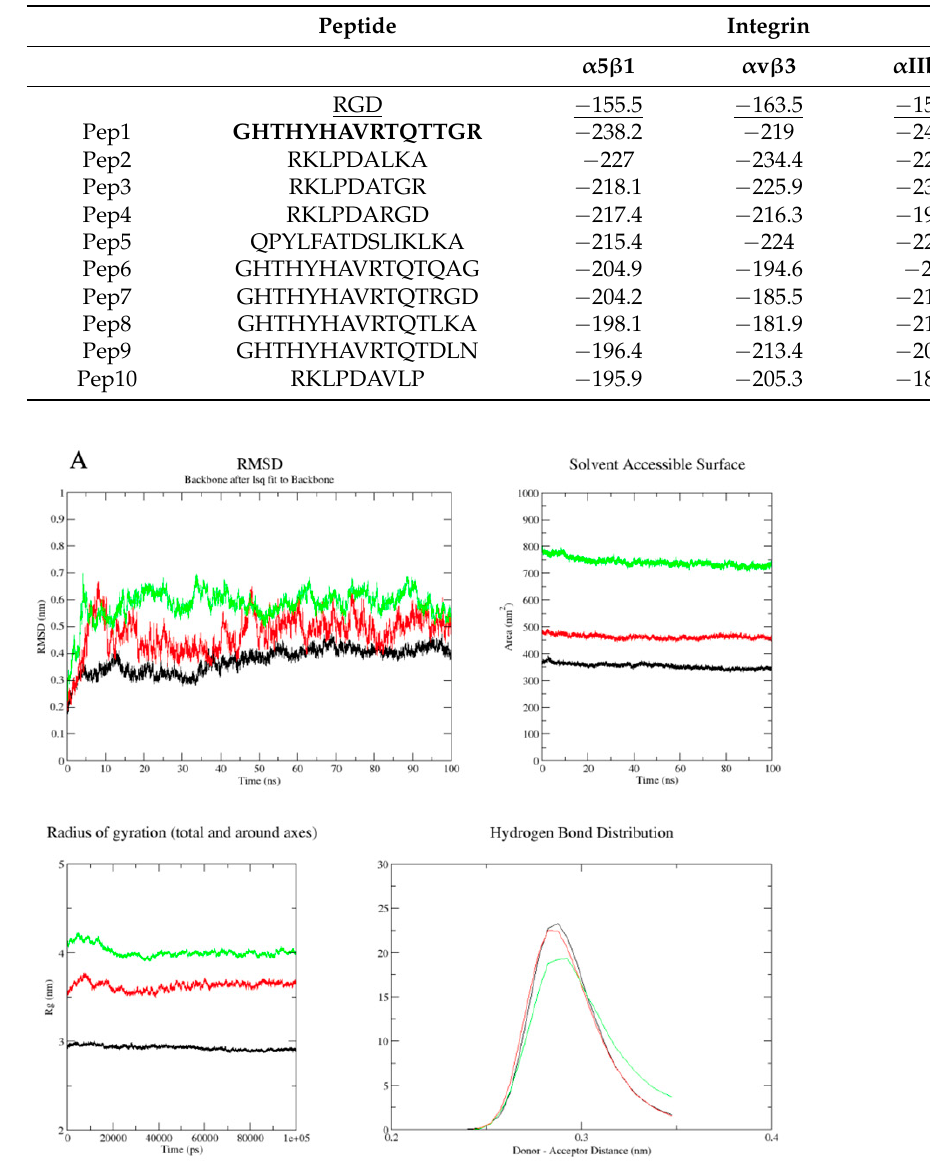
Table 2. Docking scores (VdW + Elec) of the ten peptides that demonstrated the higher binding affinity for integrin α 5 β 1 and their respective cluster scores for integrins α v β 3 and α IIb β 3. The peptides with better affinity for the integrin α 5 β 1 were chosen for a further molecular dynamics analysis because of this integrin key role in the osteogenic process. The biological ligand of the integrins (RGD motif) is underlined and is meant to serve as a comparison parameter. Peptide 1 (pep1) showed the best binding affinity when docked with the integrins α 5 β 1 and α IIb β 3, and it was the fourth best when docked with integrin α v β 3 (highlighted in bold).